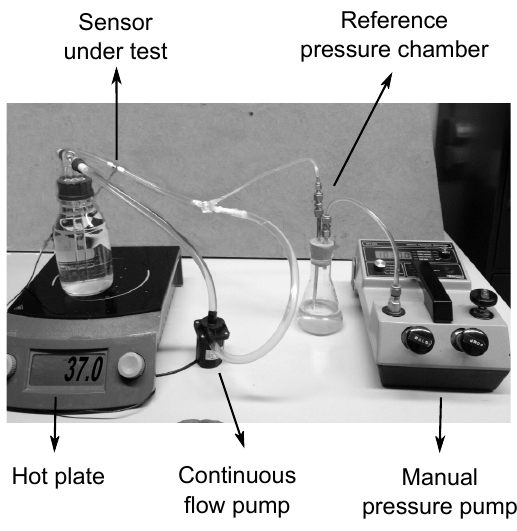
Figure 11. Experimental setup used for in vitro